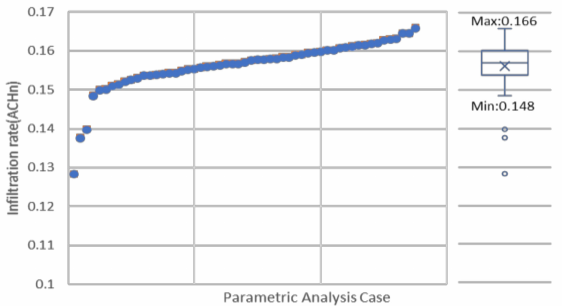
Figure 9. Natural air change per hour values (ACHn) calculation result using the parametric